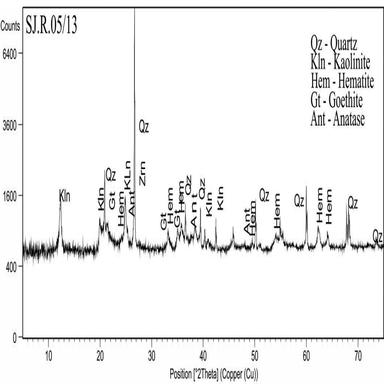
Minerals identified by XRD for an FLC sample from the lateritic profile next to FSJM (SJ.R.05/13 sample).